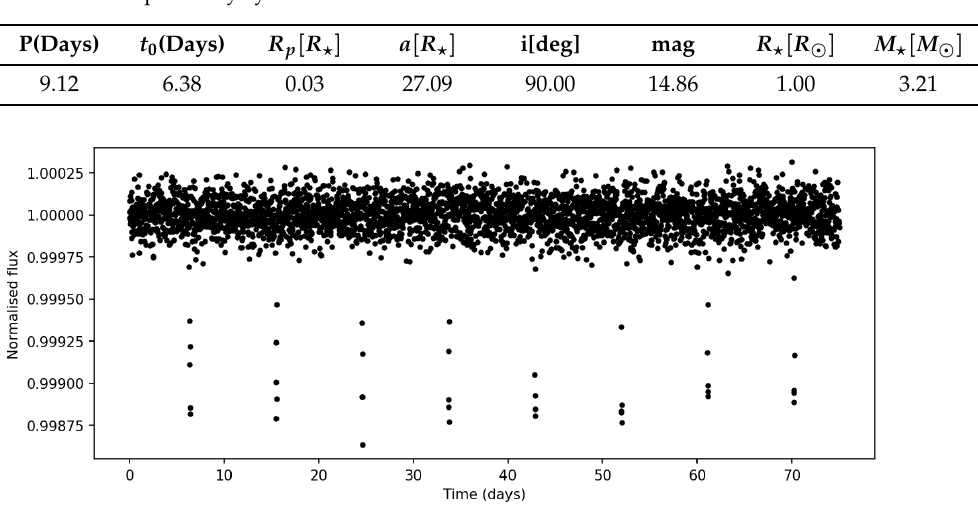
Table 1. Main parameters used to simulate one of the light curves of the training dataset. We used this simulated planetary system to check our simulations.